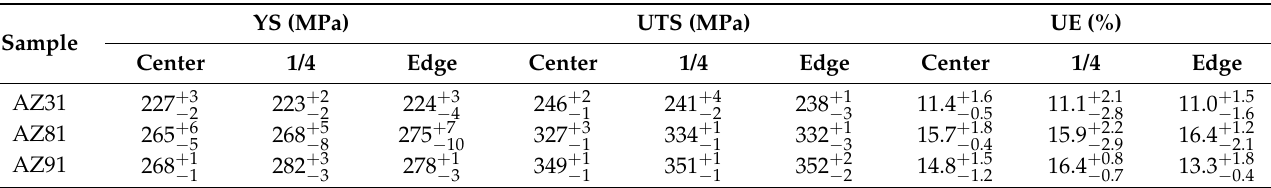
Figure 9. Stress–strain curves of as-extruded three Mg alloy sheets in different positions: ( a ) AZ31 alloy, ( b ) AZ81 alloy, ( c ) AZ91 alloy and ( d ) center area of three alloy sheets. Table 3. Mechanical properties of three different Mg alloys.